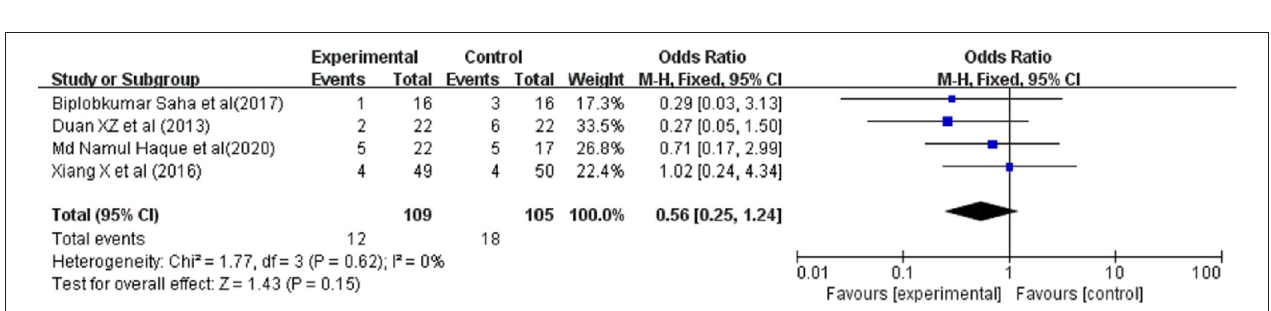
FIGURE 6 | Pooled estimate rate for bleeding between patients with ACLF. Treated by G-CSF and controls.